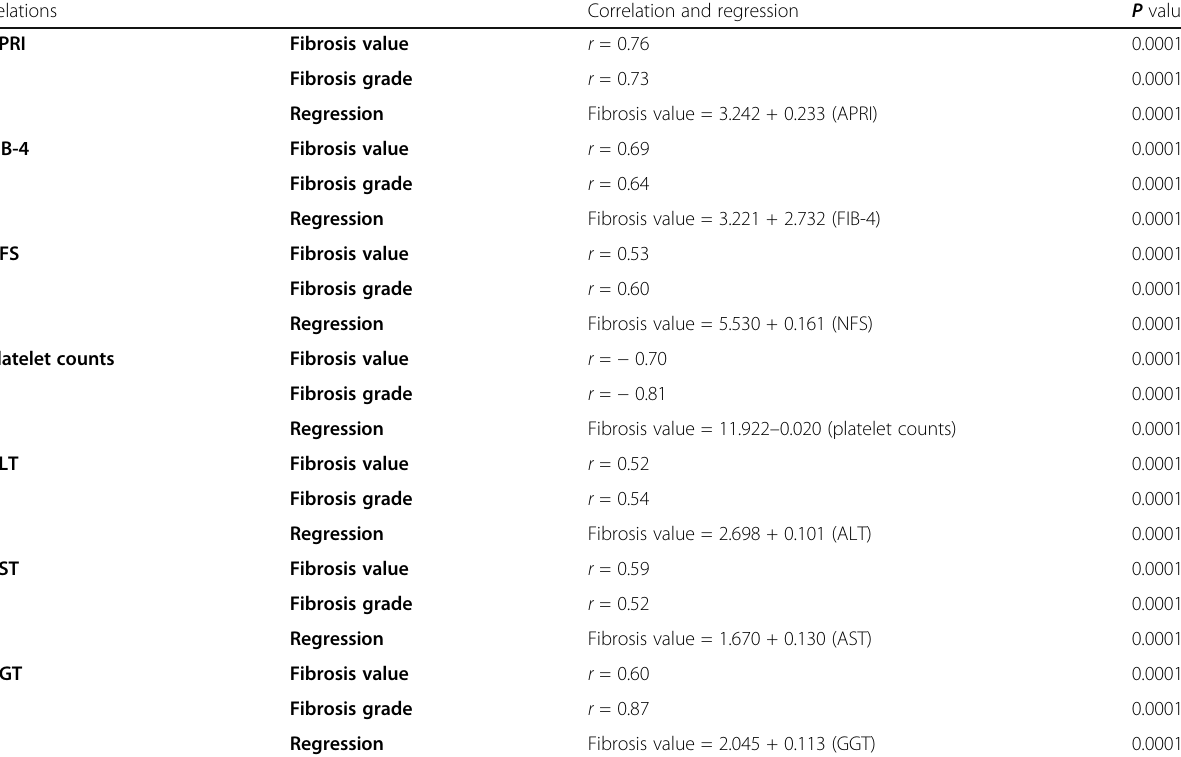
Table 2 Correlation and regression between fibrosis grades by TE and different non-invasive parameters for liver fibrosis Relations Correlation and